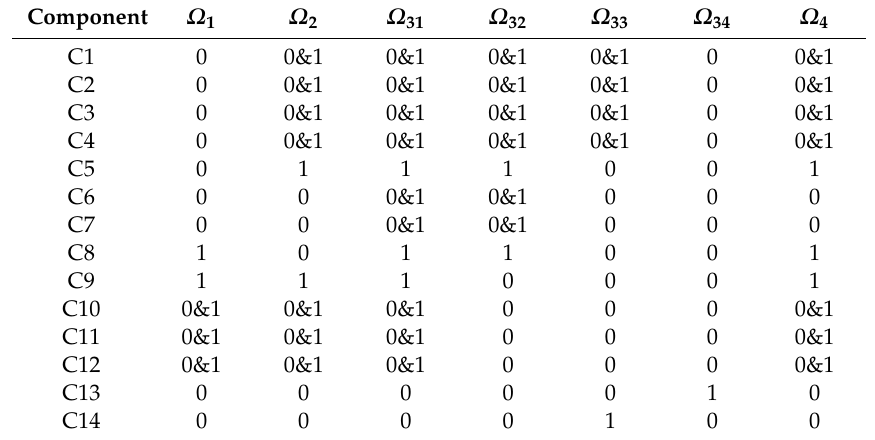
Table 1. Running status of each component in each relation of transfer in the wind power control system.